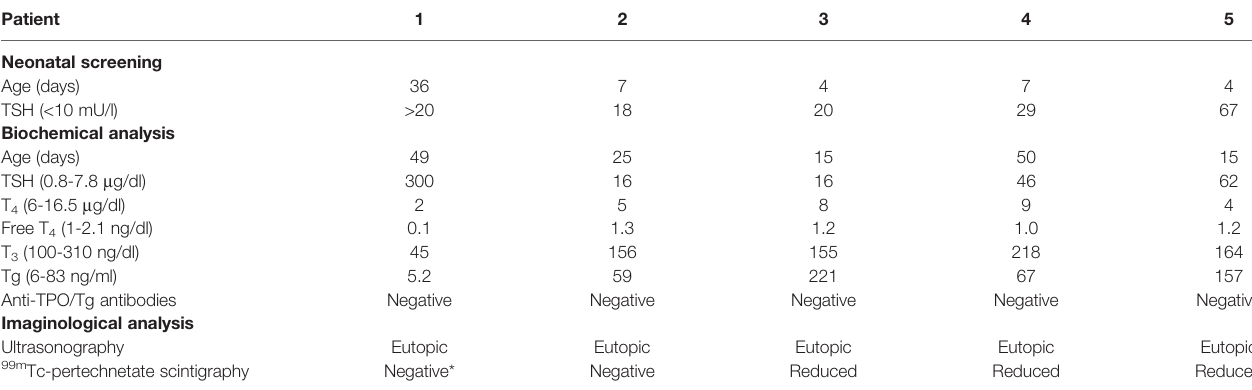
TABLE 1 | Summary of biochemical and imaginological fi